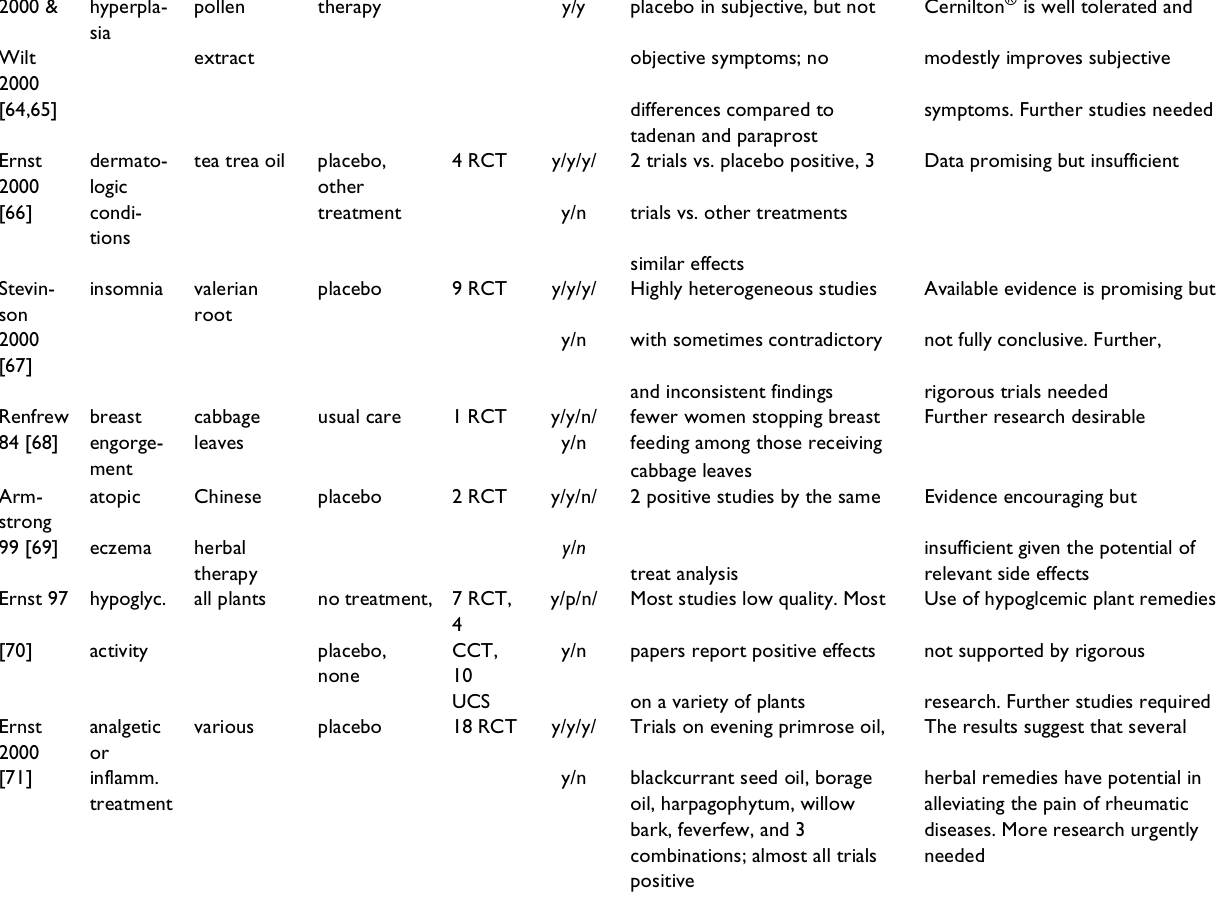
Table 4: Systematic reviews of clinical trials of herbal medicines